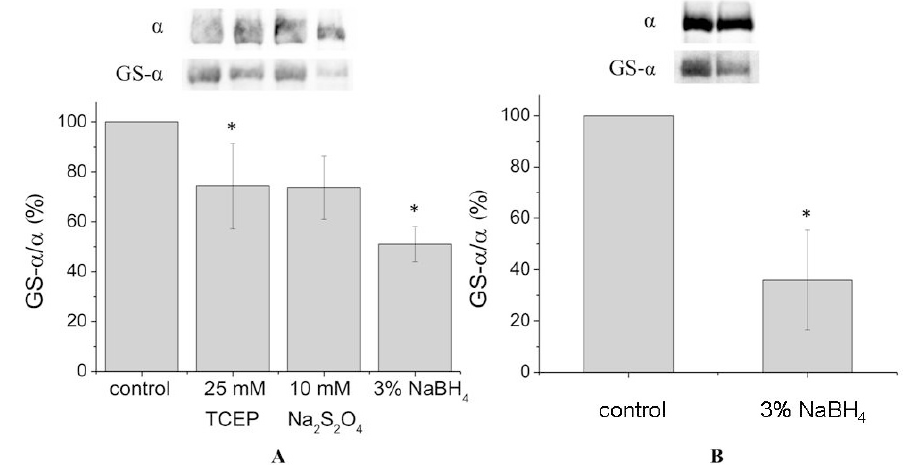
Figure 2. Deglutathionylation of α 1-subunit under denaturing conditions. ( A ) Deglutathionylation of the duck salt gland α 1-subunit (after treatment with 25 mM TCEP, 10 mM Na 2 S 2 O 4 , or 3% NaBH 4 ) in the presence of 8 M urea and 8% sodium dodecyl sulphate (SDS) for 30 min at 37 ◦ C. Results of immunoblotting after incubation of the enzyme with antibodies against bound glutathione and the α 1-subunit are presented. The results were normalized to the α 1-subunit content (number of experiments: N = 3); ( B ) Microsomes of duck salt glands after treatment with 8 M urea and 8% SDS for 30 min at 37 ◦ C. Results of immunoblotting after incubation of the sample with antibodies against glutathione and the α 1-subunit are presented. The results were normalized to the α 1-subunit content (number of experiments: N = 3). Data are presented as means ± SD of independent experiments. * p < 0.05.